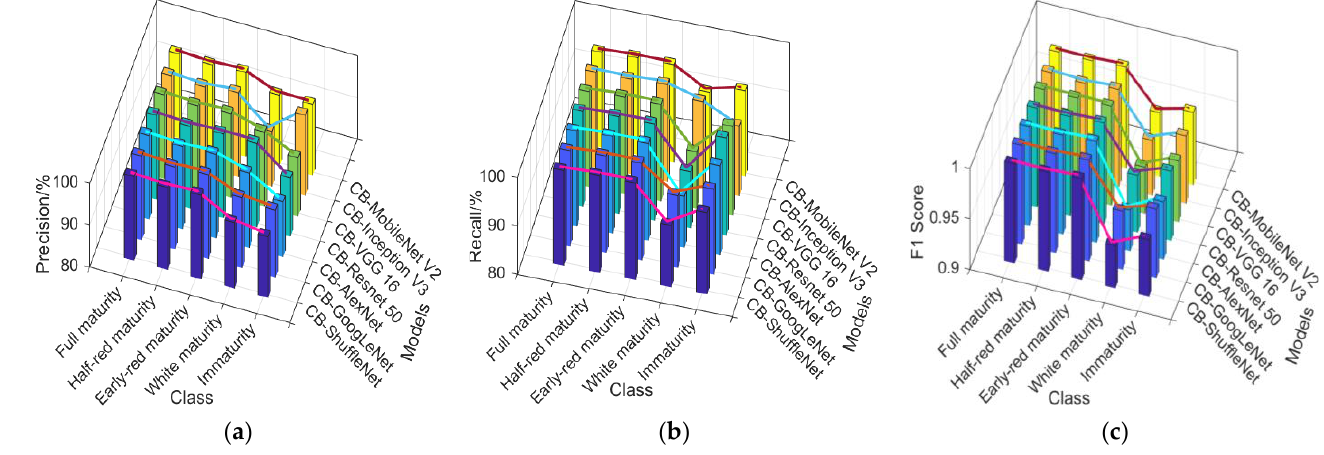
Figure 10. Precision, recall, and F1 scores of different models. ( a ) precision; ( b ) recall; ( c ) F1 score. The precision, recall, and F1 scores were above 93.069%, 90.625%, and 0.941,